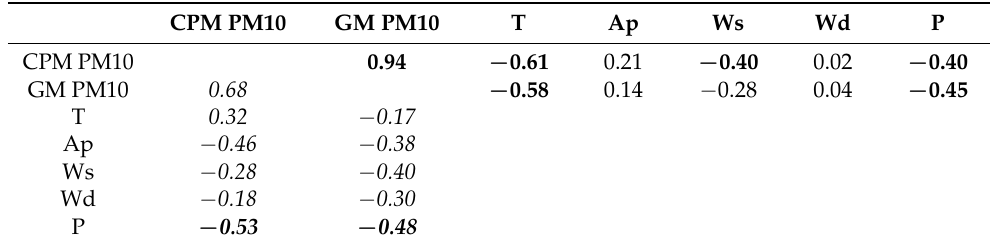
Table 4. Spearman correlation. Relationship between the PM10 concentration and meteorological parameters. Bold values are statistically significant with p = 0.05. Normal font relates to winter data and italic font to spring